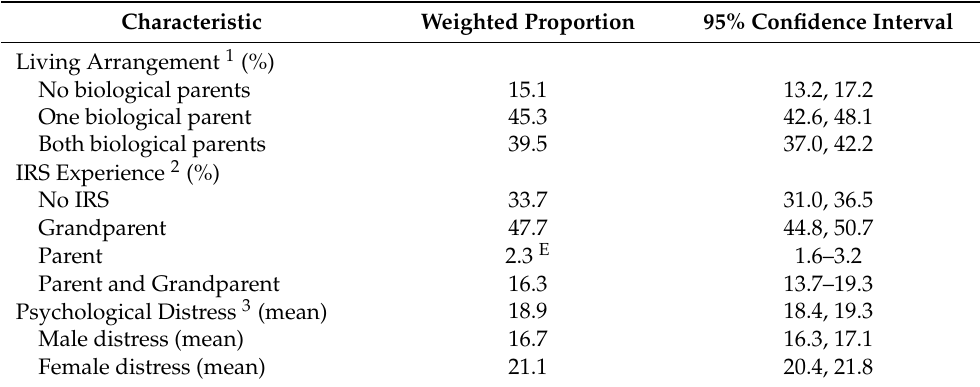
Table 1. Characteristics of First Nations youth living on reserve and in northern communities across Canada (Source: FNIGC, “2018-MCQUR-001-2020 Apr 16-Youth”, 16 April 2020).